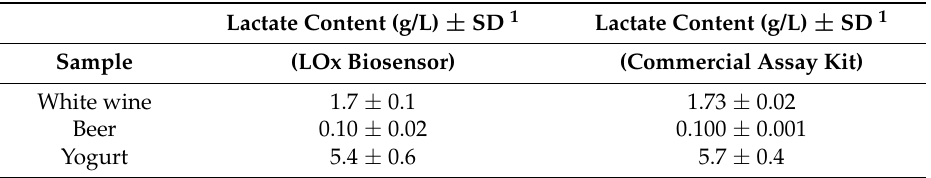
Table 2. Determination of lactate in different samples with the biosensor and with a commercial enzymatic assay